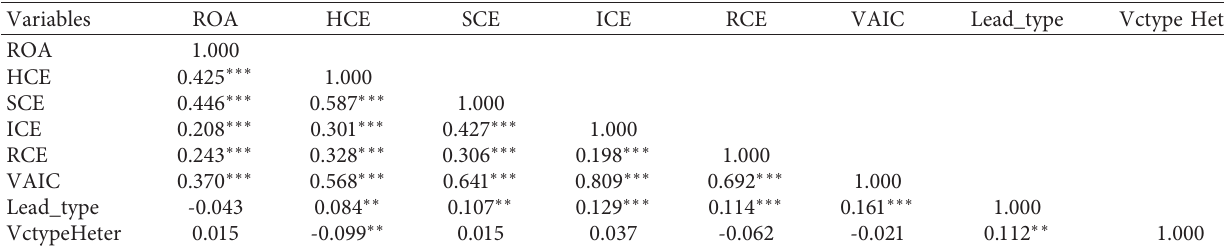
Table 4: Correlation matrix for main study variables.